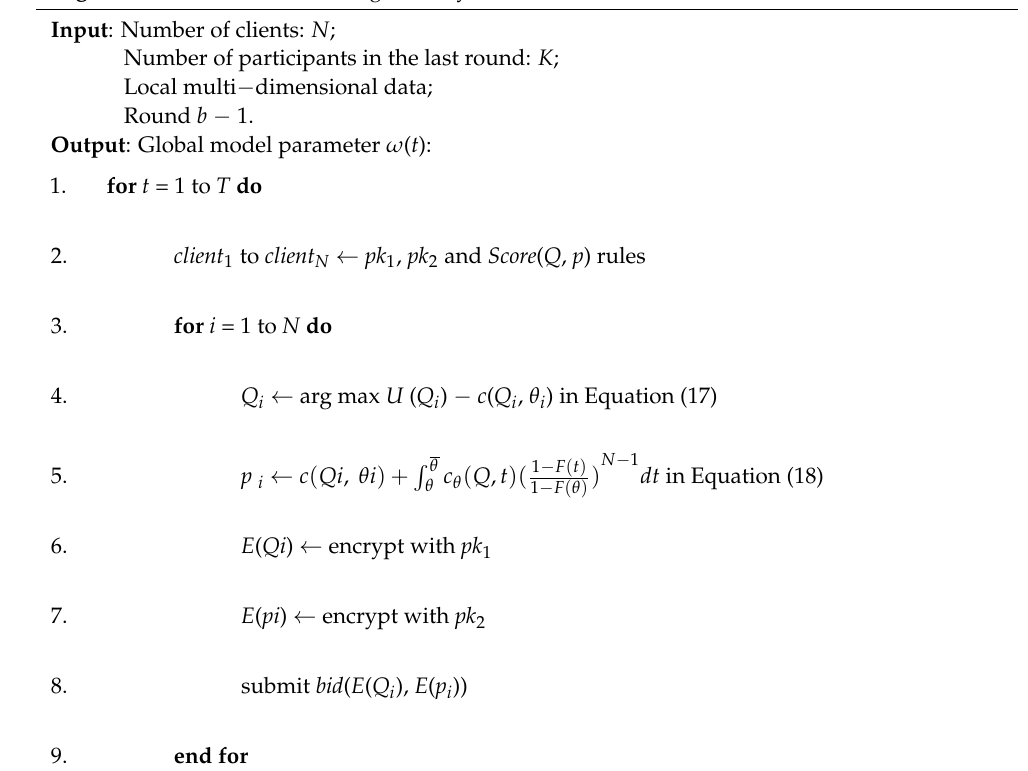
Algorithm 1: Federated Learning Security Mechanism in Round